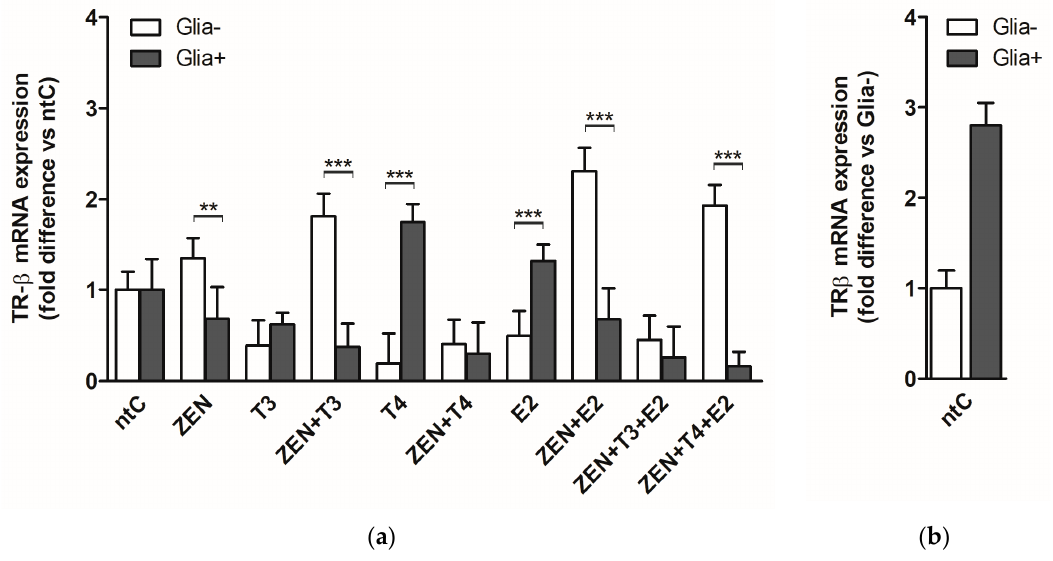
Figure 3. TR β mRNA expression in cerebellar granule cells in the absence, Glia − , or presence of glial cells, Glia+; treated with zearalenone (ZEN), and/or triiodo-thyronine (T3), thyroxine (T4) and 17 β -estradiol (E2) for 6 h. ( a ) Relative expression level of the TR β gene was analyzed by qRT-PCR and normalized to the average of the control gene β -actin. Shown p -values were calculated: Glia+ compared to Glia − (**) p < 0.01, (***) p < 0.001 in each treatment group. ( b ) Relative expression of TR β mRNA in non-treated controls normalized to β -actin ( p -value not shown). The data shown here are the mean ± SD of at least three independent experiments ( n = 6 per treatment).